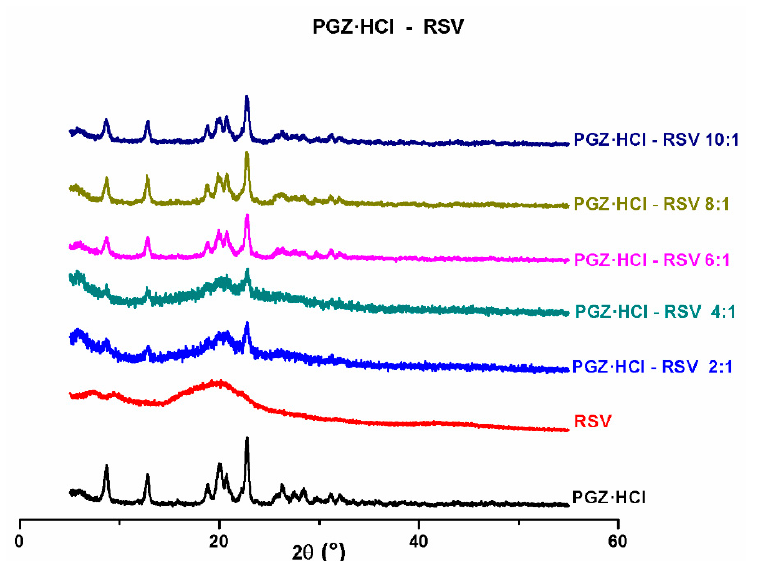
Figure 8. XRPD diffractograms of the solid forms of PGZ·HCl-RSV at different stoichiometric ratios (2:1, 4:1, 6:1, 8:1, and 10:1).